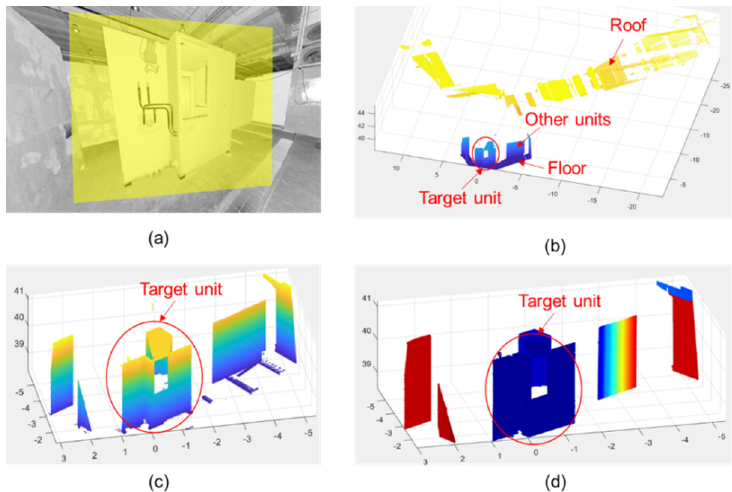
Figure 13. Data cleansing: ( a ) selection of scanned data surrounding the target unit, ( b ) 3D view of the selected scanned data, ( c ) scanned data after removing the roof and floor, and ( d ) extraction of the target unit using region